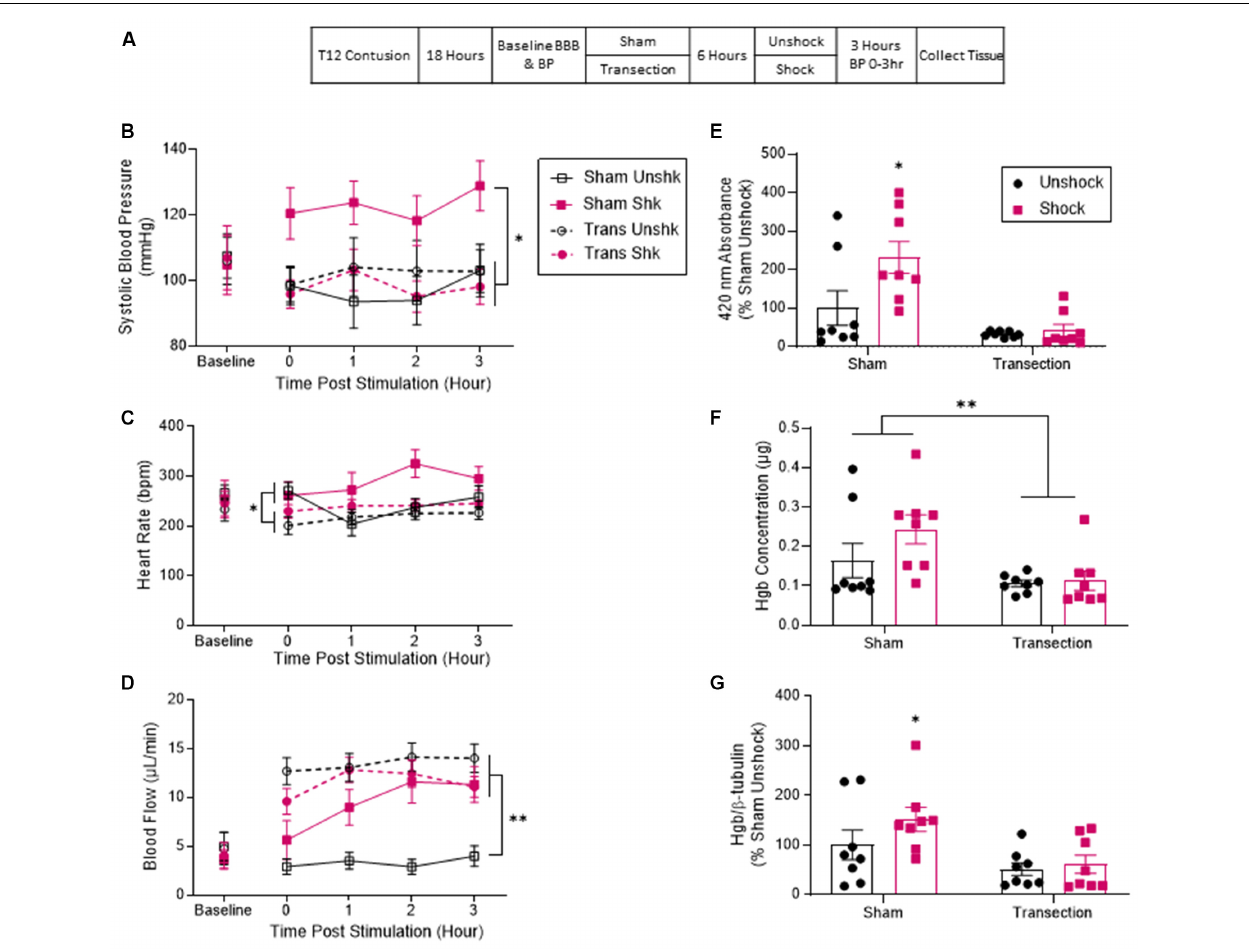
FIGURE 1 | Noxious electrical stimulation increased BP and hemorrhage after a lower thoracic contusion injury and this effect was blocked by a spinal transection. (A) Experimental design and timeline for experiment 1. (B) Sham-operated rats that received electrical stimulation (Shk) exhibited higher systolic blood pressure over the next 3 h (T0–T3). Transection surgery blocked this effect. (C) Rats treated with electrical stimulation exhibited higher heart rate over the 3 h. (D) Both transected groups and the sham-operated rats that received shock displayed a significant increase in tail blood flow. Sham-operated unshocked animals remained unchanged. (E) Quantification of peak absorbance at 420 nm (the wavelength associated with hemoglobin). Sham shocked rats showed a higher peak absorbance than unshocked rats. Transection surgery blocked this effect. (F) Quantification of hemoglobin content based on formation of cyanomethemoglobin (Drabkin’s assay). Tissue from sham shocked rats contained a higher concentration of hemoglobin relative to animals that had undergone a spinal transection. (G) Immunoblot quantification for hemoglobin showed that tissue samples from sham-operated rats that received shock had higher levels of hemoglobin relative to both the sham-operated unshocked group and both groups that received a transection. Asterisks indicate statistical significance ( ∗ p < 0.05, ∗∗ p < 0.01, n = 8). An asterisk placed over a group indicates that the group differs from all the others. Error bars represent the standard error of the mean